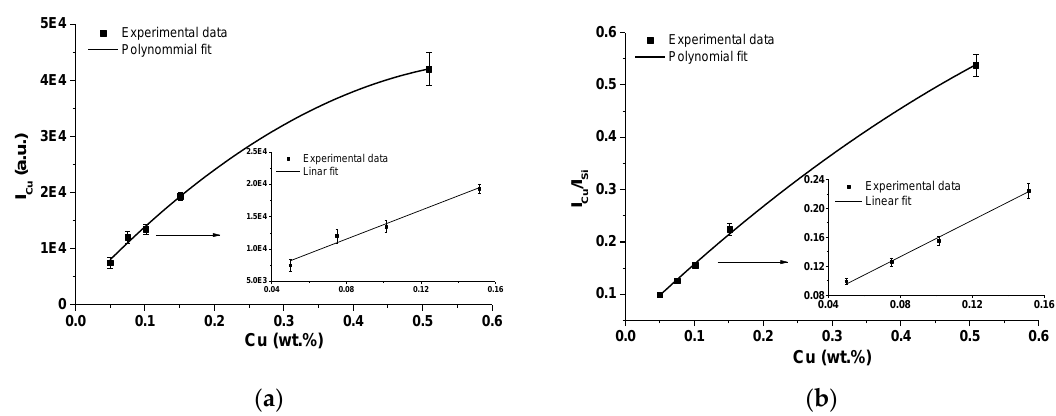
Figure 6. (a) Calibration curves of copper obtained using of Cu I 324.75 nm line and linear fit of first four data points; (b) calibration curve of Cu I 324.75 nm line with using of Si I line as an internal standard and linear fit of first four data points (error bars represent relative standard deviation (RSD) of used data).